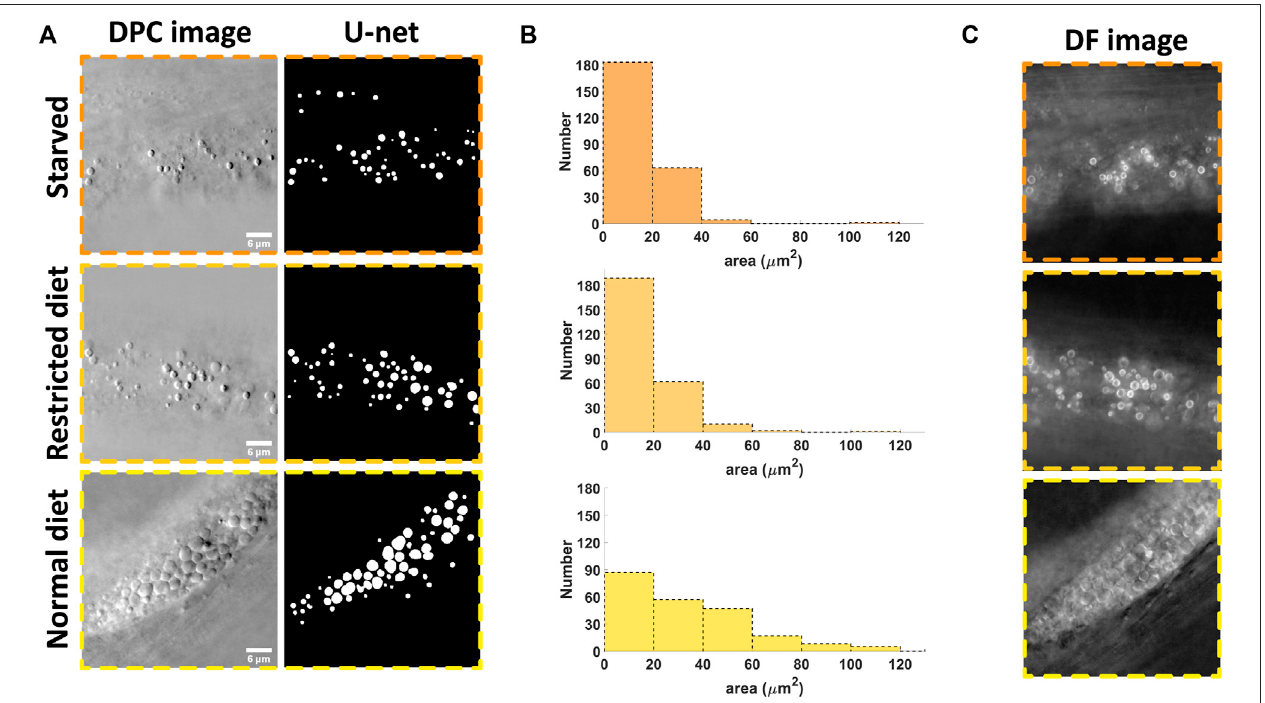
FIGURE4| Resultsofthestarvationexperimentationwherethenumberandsizeofthelipiddropletsareanalyzed. (A) exampleoftherawdataandthesegmented results for three different state: starved, restricted diet and normal diet; (B) The morphology analysis based on 5 images for each case; (C) In starved state, the lipid droplets become bright ring-like in the dark fi eld image, signifying the strong variations in refractive index compared to those with normal state. Scale bars in (A) represent 6 μ m .